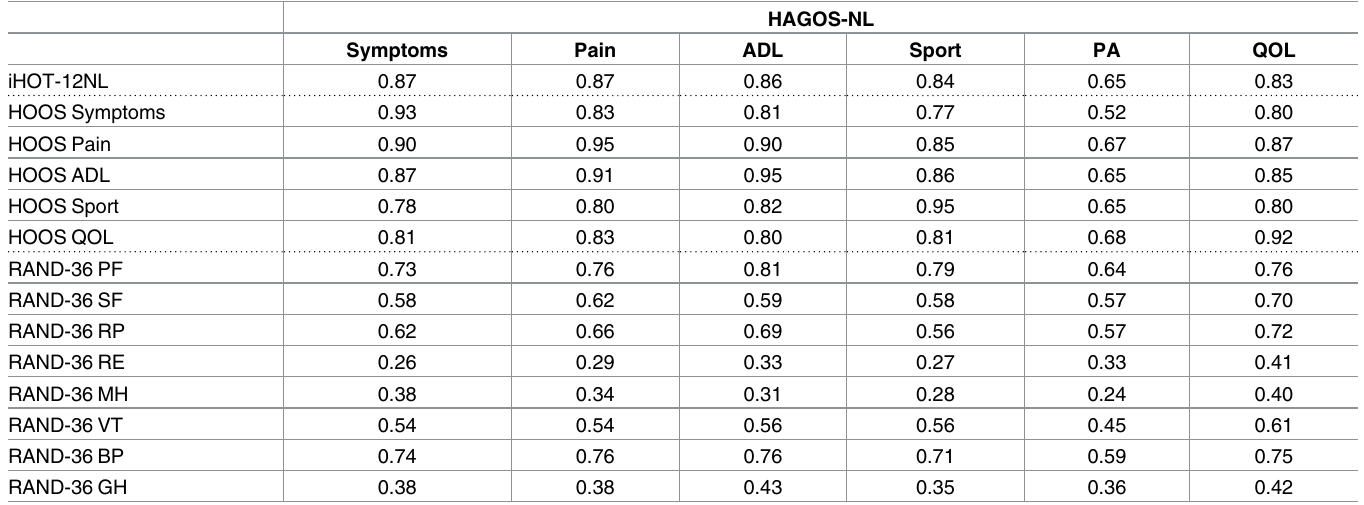
Table 4. Spearman’scorrelation coefficients between HAGOS-NL subscales and iHOT-12NL, HOOS subscales and